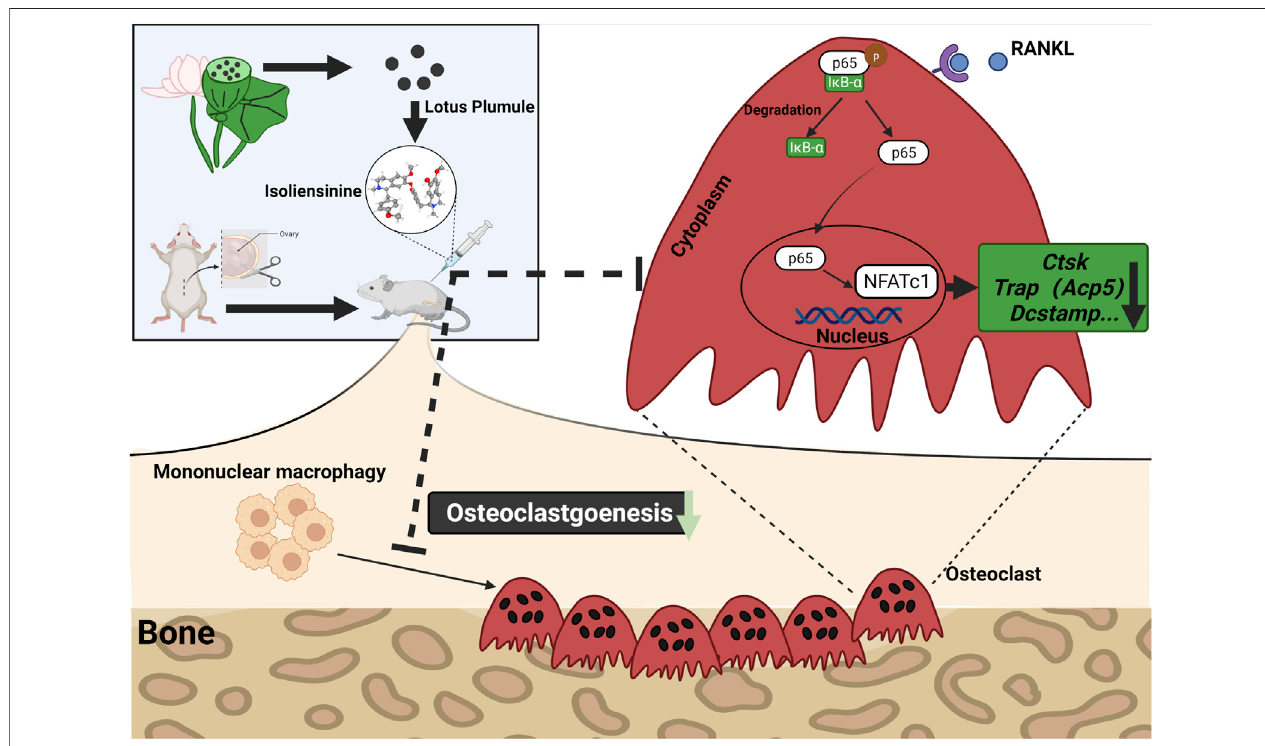
FIGURE 8| Iso treatment reduces the production ofosteoclasts in ovariectomized mice. A proposed scheme for the inhibition ofIso on osteoclastogenesis. Upon RANKL binding to RANK, NF- κ B pathways are activated, leading to the ampli fi cation of NFATc1. Several osteoclast-speci fi c genes such as c-Fos, Ctsk, Trap, and Dc-stamp are upregulated as a result. RANKL: receptor activator of nuclear factor- κ B ligand. NF- κ B, nuclear factor- κ B; NFATc1, nuclear factor of activated T cells 1, c-fos, Proto-oncogene, Ctsk, cathepsin K; Trap, tartrate-resistant acid phosphatase; Dc-stamp, dendritic cell-speci fi c transmembrane protein.